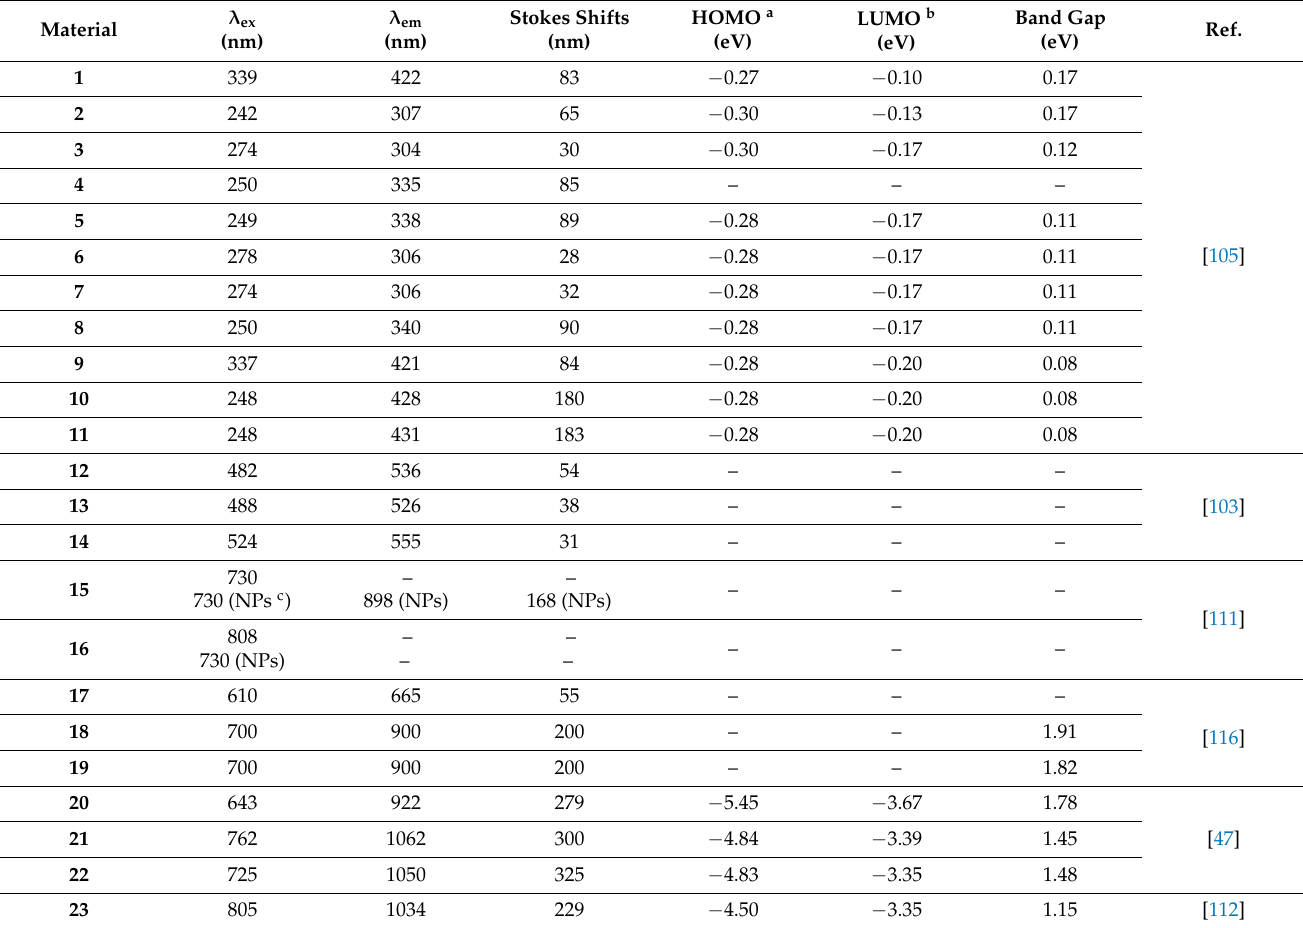
Table 3. Summary of the optical properties with small molecule-based photoluminescence